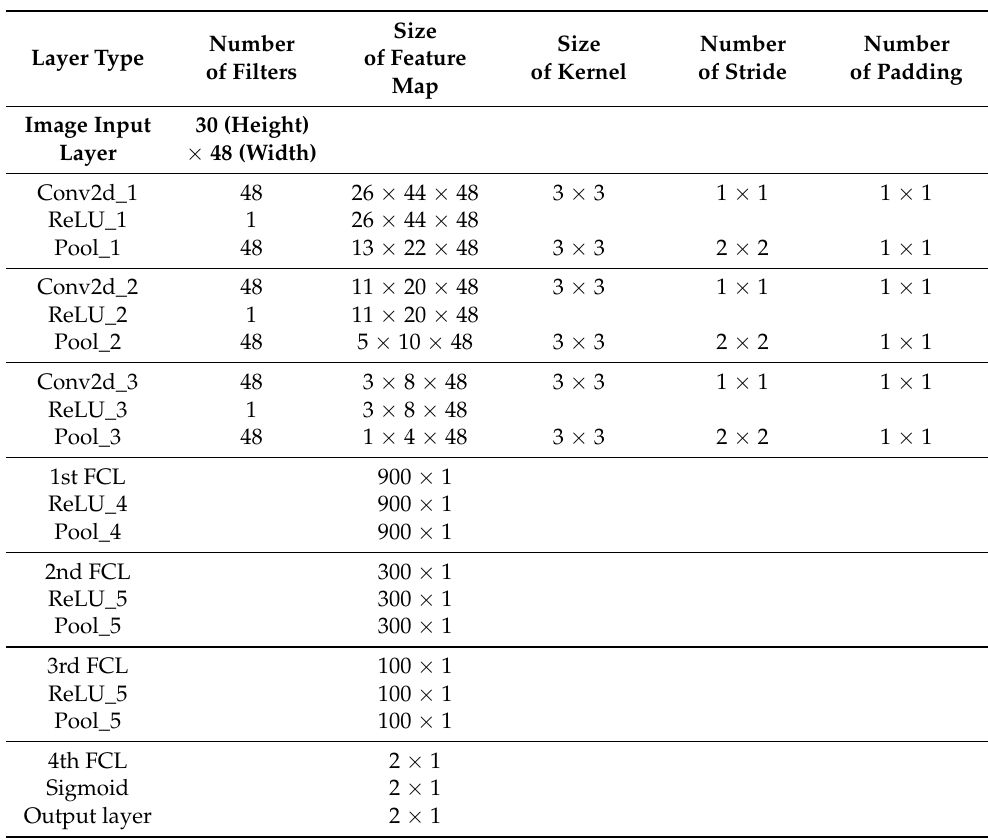
Table 1. 2D-CNN architecture used in our research (i.e., Conv, ReLU, Pool, and FCL mean convolu- tional layer, rectified linear unit, max pooling layer, and fully connected layers, respectively). Number Layer Type of